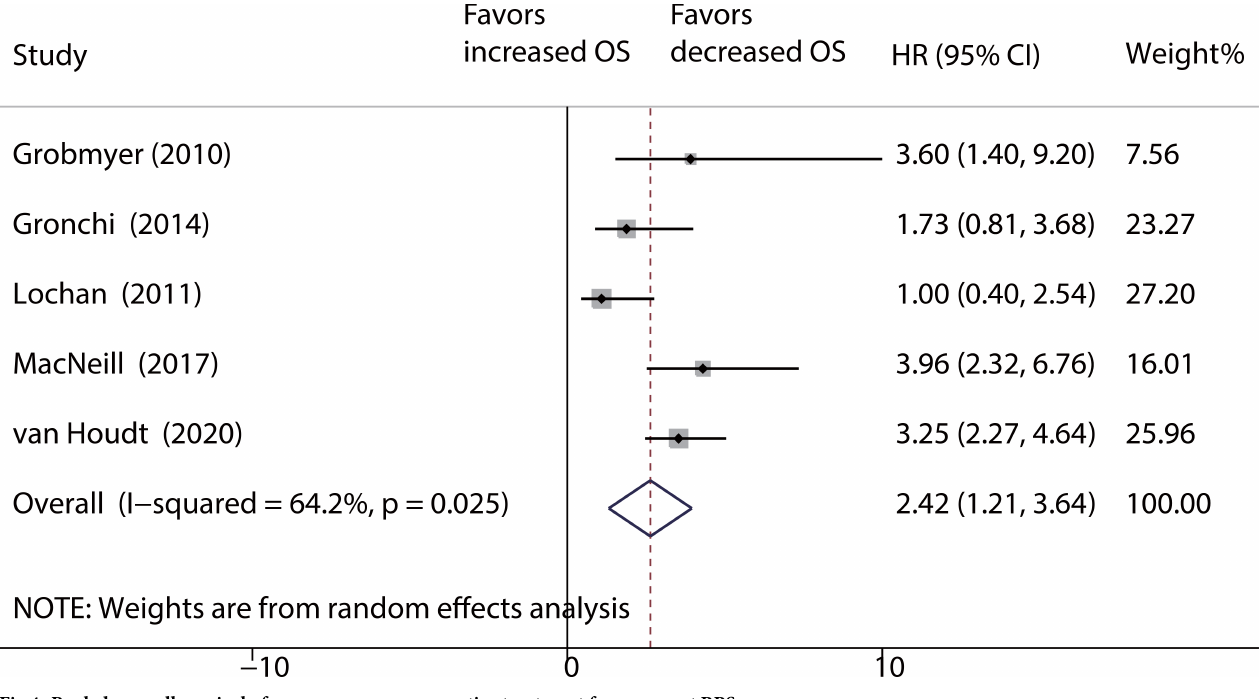
Fig 4. Pooled over-all survival of surgery versus conservative treatment for recurrent